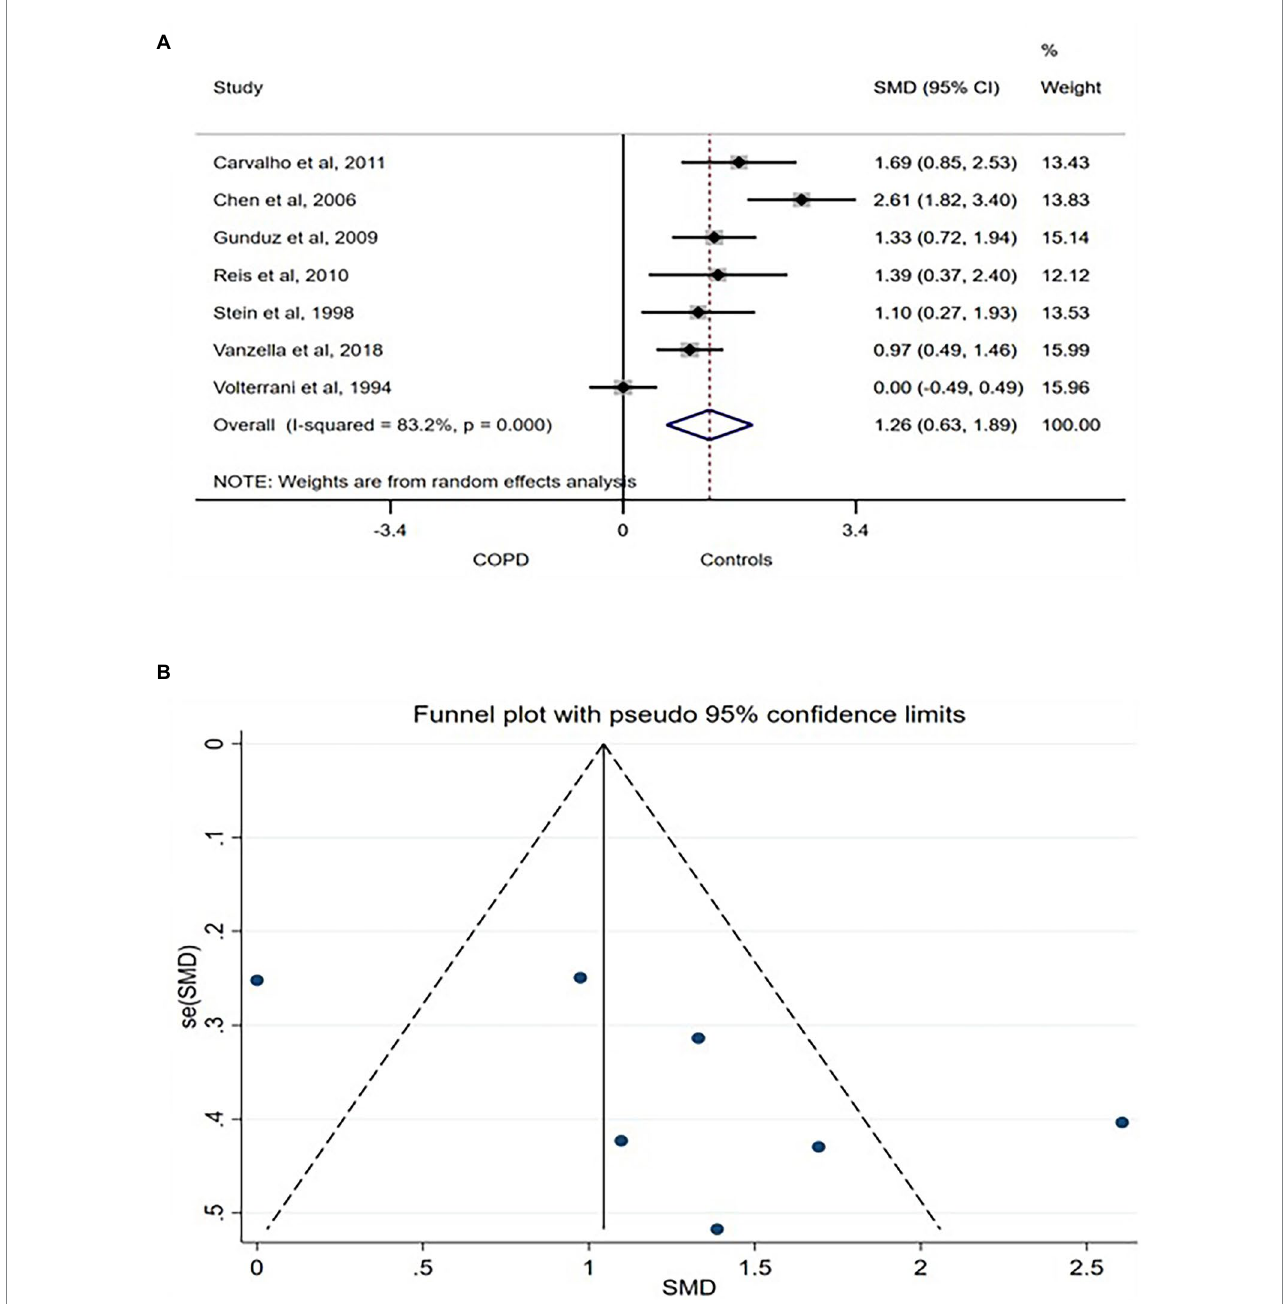
FIGURE 2 SDNN forest plot (A) showing the SMD and funnel plot (B) assessing the presence of publication